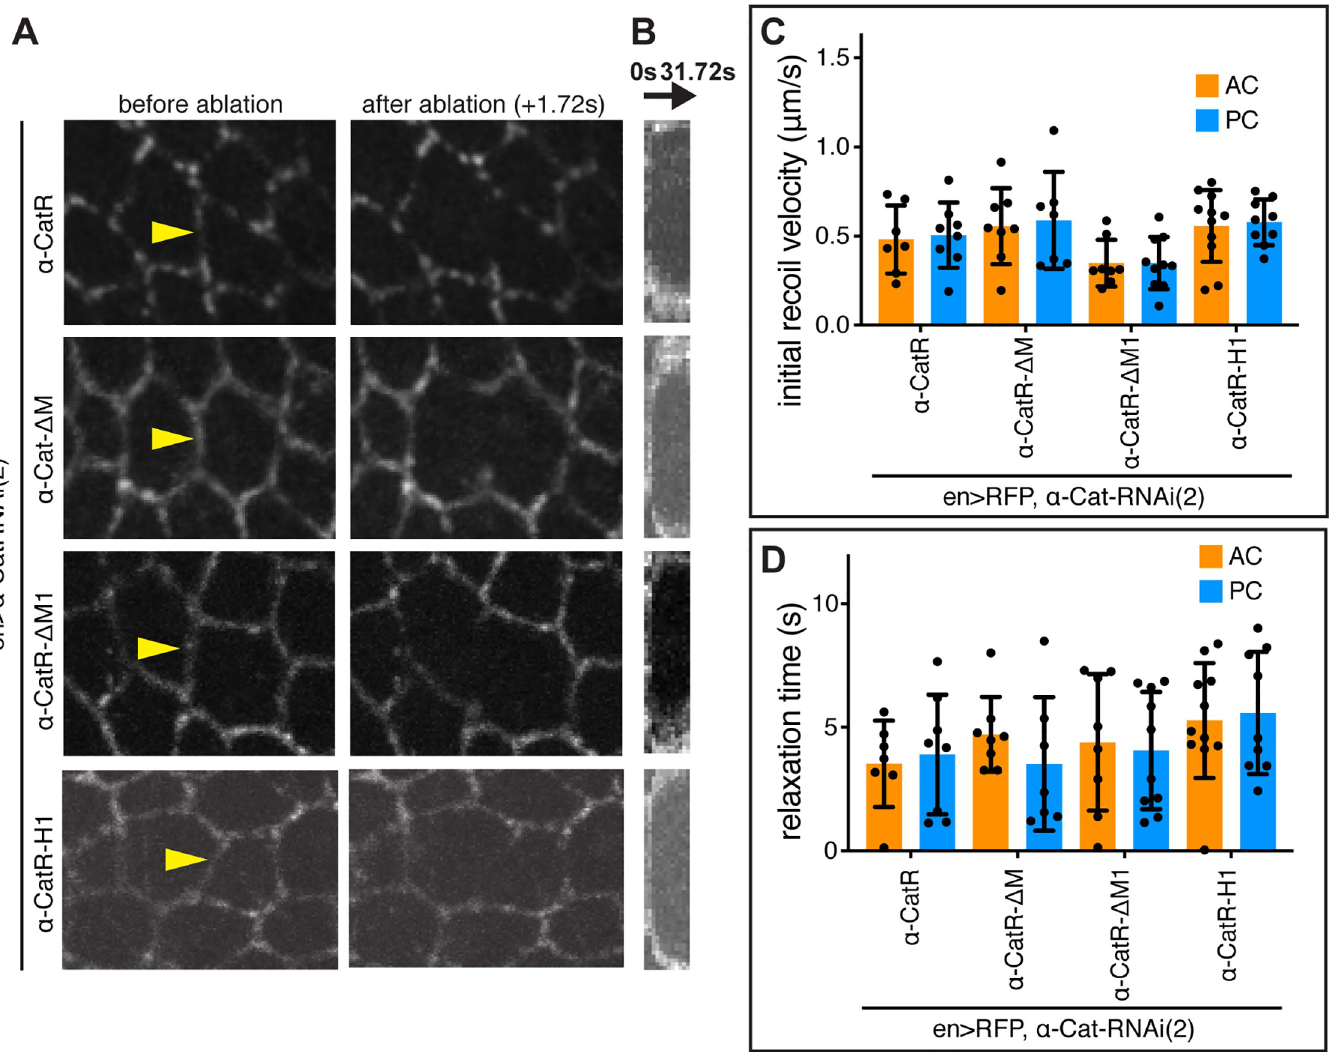
Fig 9. α -Cat mechanosensory mutants do not alter tissue tension. (A) Late 3rd larval instar wing imaginal discs expressing Jub::GFP, en-Gal4 , UAS-RFP , UAS- α -Cat- RNAi(2) , and either UAS- α -CatR , UAS- α -Cat- Δ M , UAS- α -CatR- Δ M1 , or UAS- α -CatR-H1 . Junctions were cut with a laser pulse (see Materials and methods) at the sites indicated by the arrowheads. Initial recoil velocity (C) and relaxation time (D) was determined from movie sequences. (B) Kymographs demonstrating the displacement of adjacent cell vertices of the ablated cell edge shown in (A) which was used to determine the relaxation time (D). (C,D) Quantification of initial recoil velocities (C) and relaxation time (D) of cell edges after laser ablation in wing discs of indicated genotypes. 3–5 discs were used per genotype, and only data for which relaxation times could be calculated with confidence were included. No significant differences between anterior and posterior cell edges were observed for either dataset (Mann-Whitney test).